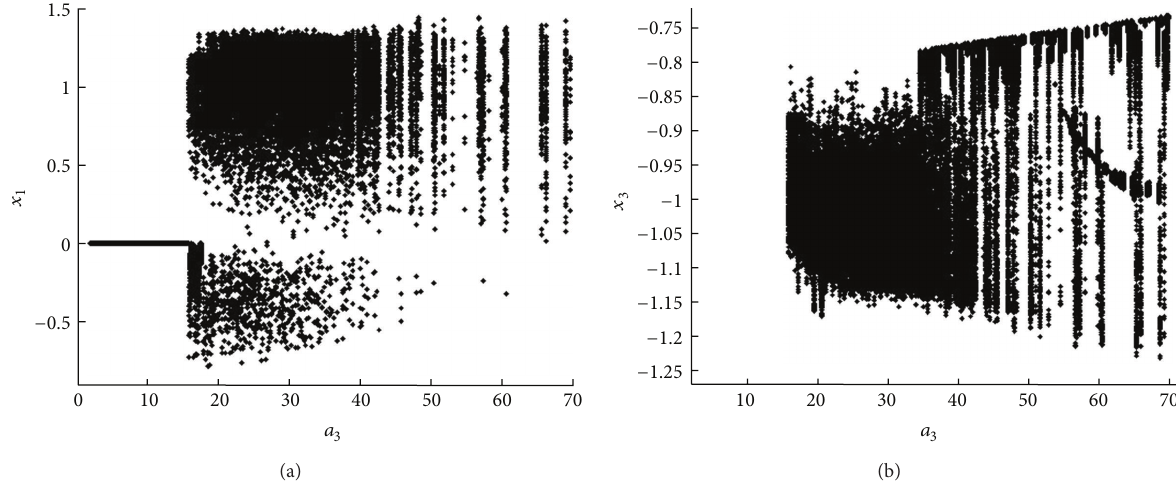
Figure 9: The bifurcation diagram is obtained for the in-plane excitations 𝑎 3 = 2 ∼ 70, 𝑓 2 = 55.1 , 𝜇 1 = 0.1 , 𝜇 2 = 0.1 , and 𝑎 2 = 11.59 ; (a) the bifurcation diagram on the plane (𝑥 1 , 𝑎 3 ) ; (b) the bifurcation diagram on the plane (𝑥 3 ,𝑎 3 ) .